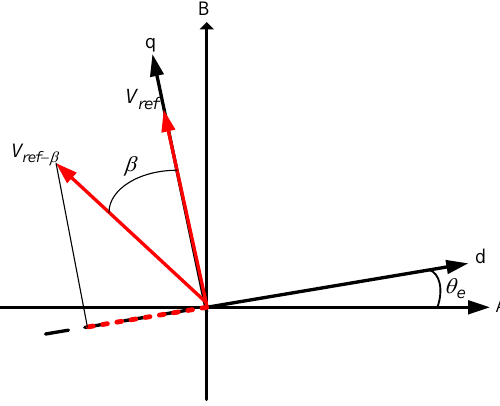
Figure 4. The vector control for phase currents.